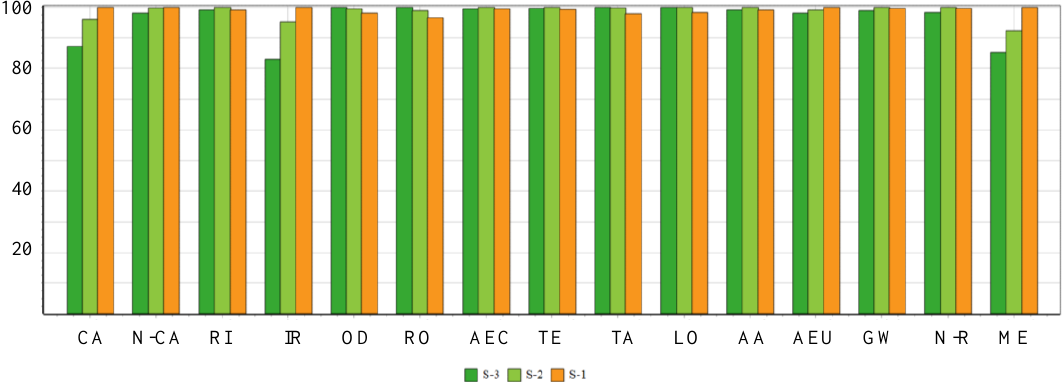
Figure 6. Midpoint life cycle impacts of studied municipal solid waste management (MSWM)systems